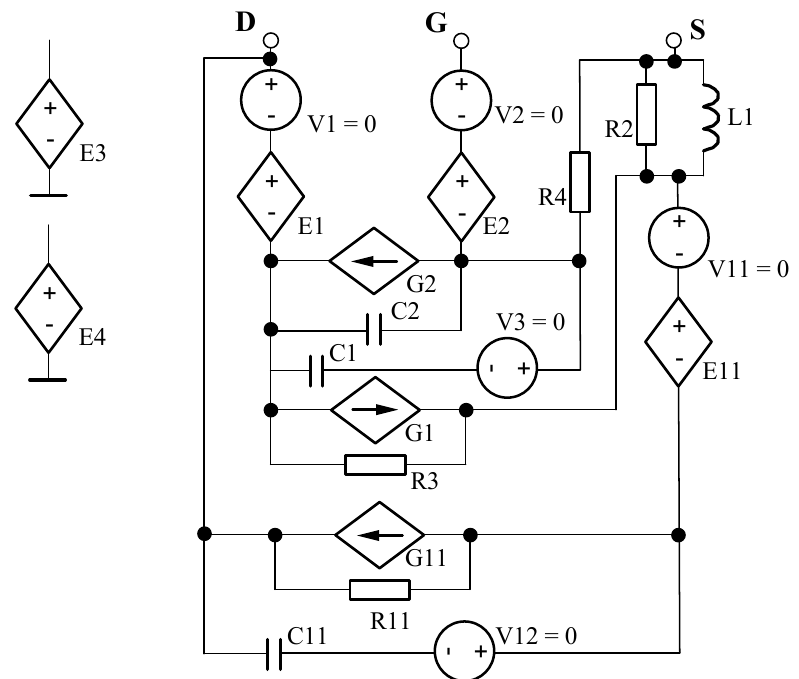
Figure 1. Network representation of the model of a SiC-MOSFET given in [32].